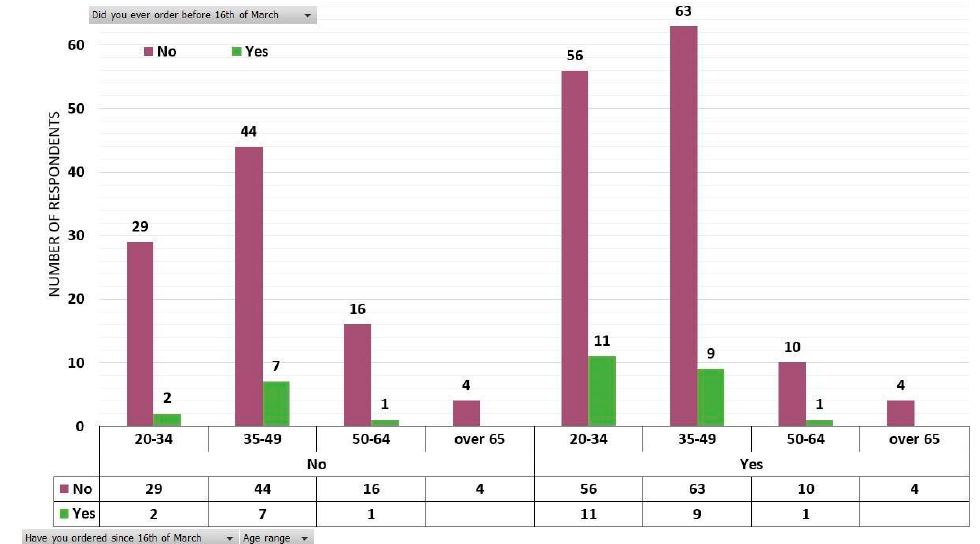
Figure 5. The clusters of those who have declared that they bought or did not buy fresh vegetables from local producers with direct delivery, before March 16, distributed according to age categories and statement that they bought or did not buy directly from producers after March